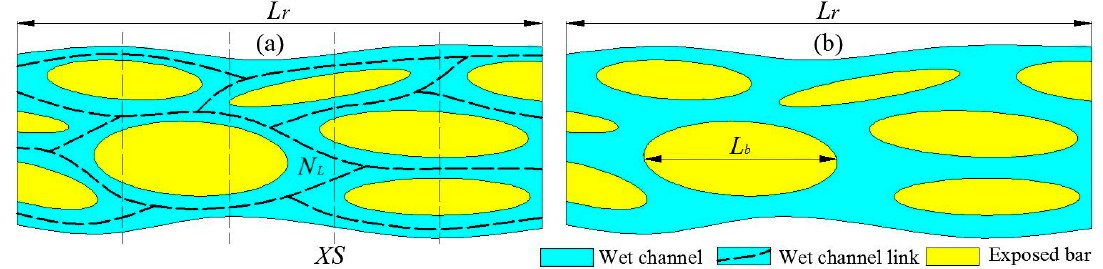
Figure 2. Diagrams of the parameters used for calculating braiding number and bar length indices (modified based on [41]).